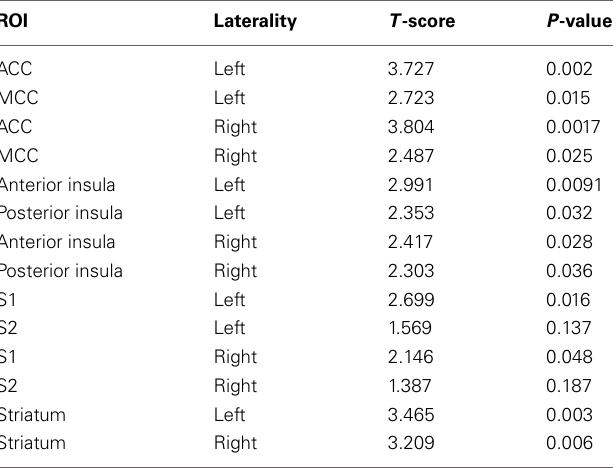
Table 1 | Results from hand drawn VOIs in the pain matrix based upon comparison between viewing likable with hateful people in pain.